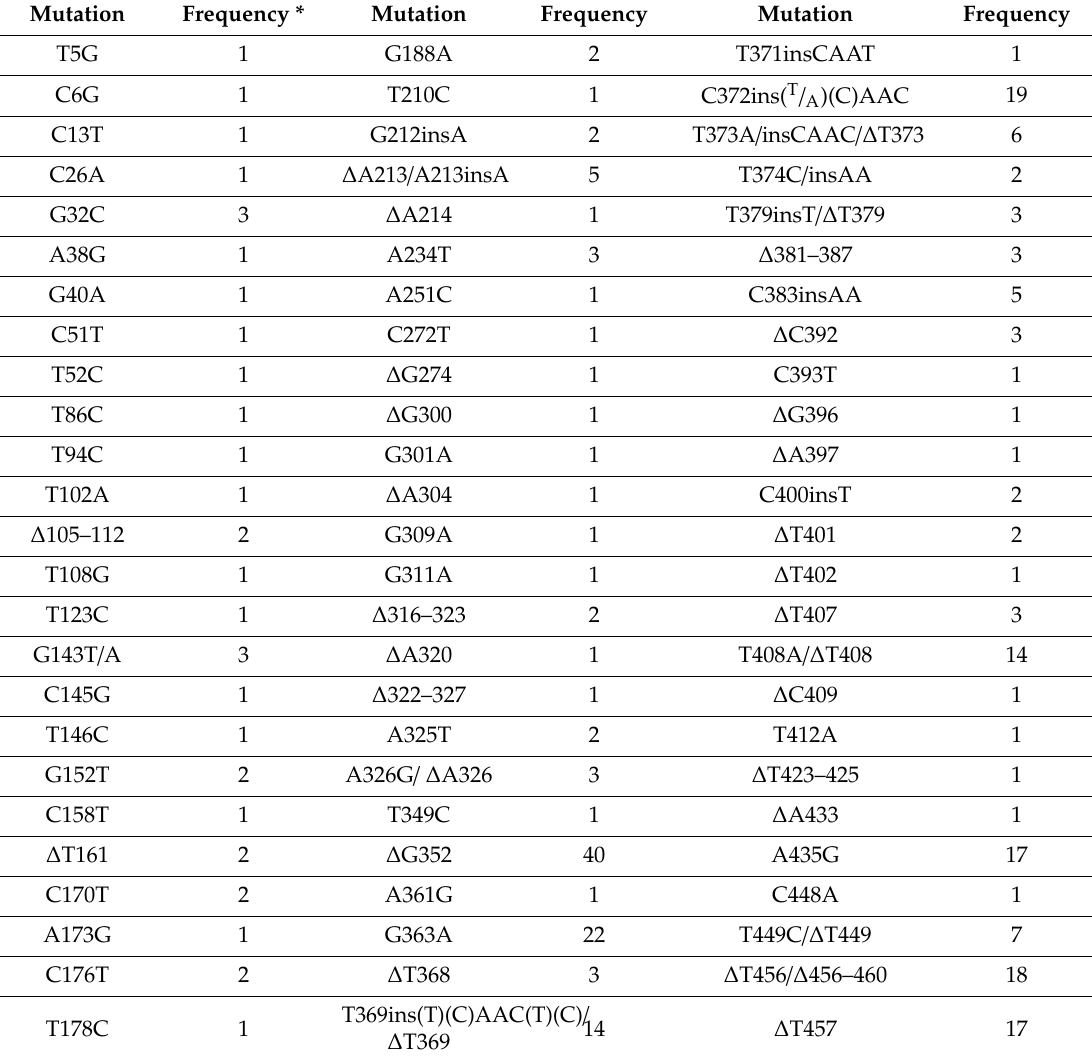
Table 6. Frequency of mutations in the noncoding control region of Merkel cell polyomavirus. Mutation Frequency *